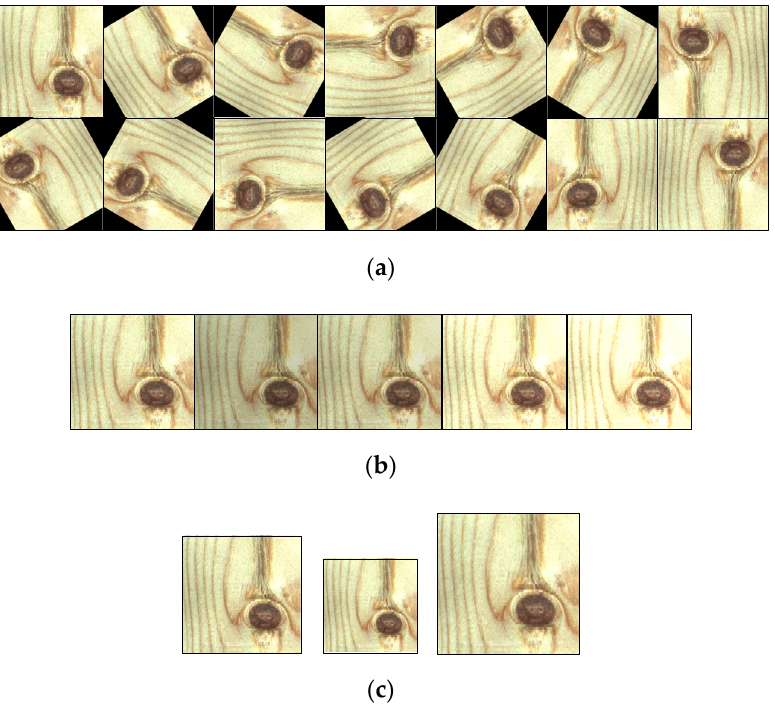
Figure 3. Image data enhancement. ( a ) Mirrored or rotated images at different angles. ( b ) Changed image contrast. ( c ) Scaled image at a scale of 0.8 and 1.2.